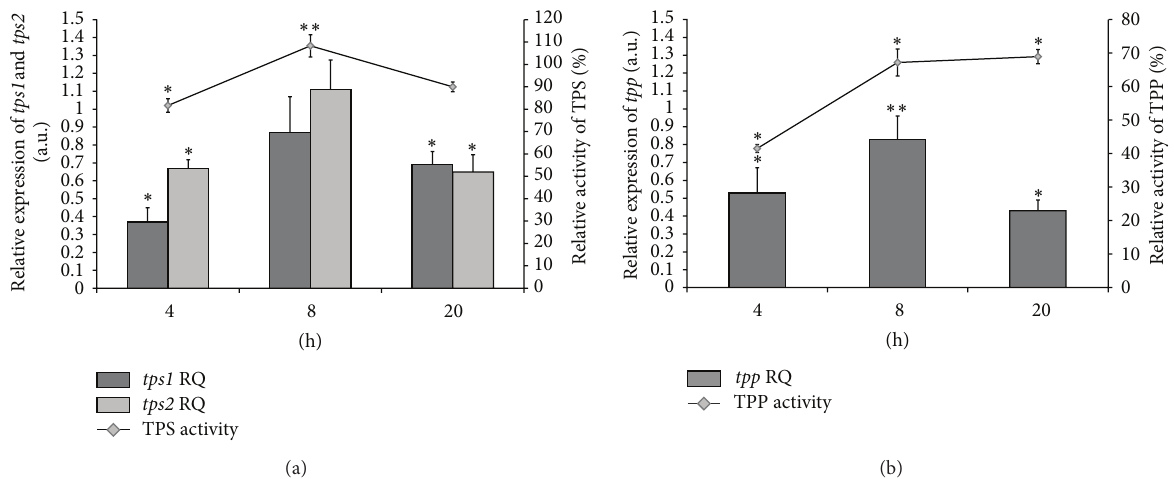
Figure 3: Relative activity of trehalose-6-phosphate synthase (TPS) and phosphatase (TPP) and their mRNA expression ( tps1 , tps2 , and tpp genes) normalized to the endogenous reference gapdh (glyceraldehyde-3-phosphate dehydrogenase) gene and relative to the control groups. IVM: ivermectin; RQ: relative quantification; (a) relative activity of TPS and tps1 , tps2 expression; (b) relative activity of TPP and tpp expression; ∗ significant change at 𝑃 < 0.01 and ∗∗ significant change at 𝑃 < 0.05 with respect to the control